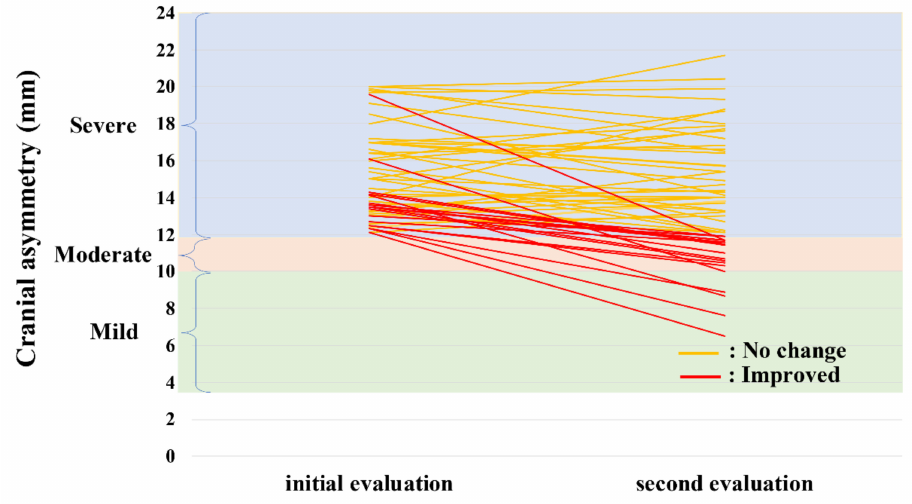
Figure 5. Initial and second evaluation CA values of infants with plagiocephaly in the improved and no-change group. CA, cranial